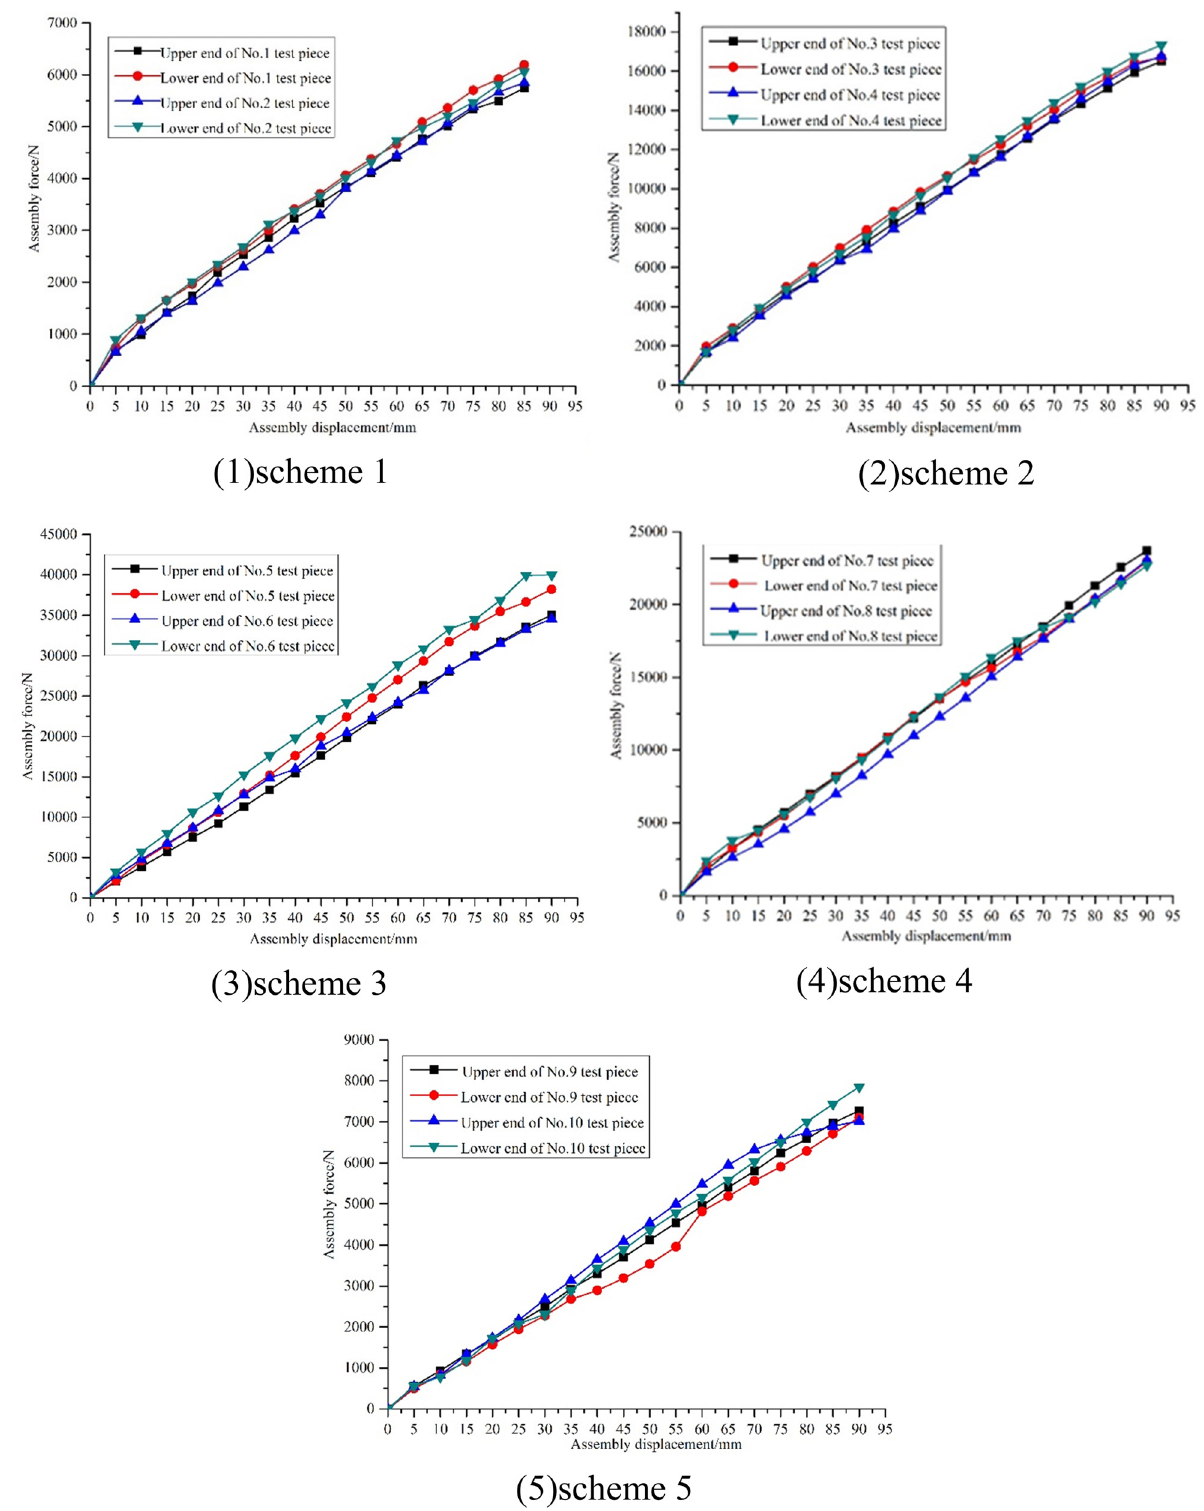
Figure 15: Assembly force – displacement relationship in di ff erent